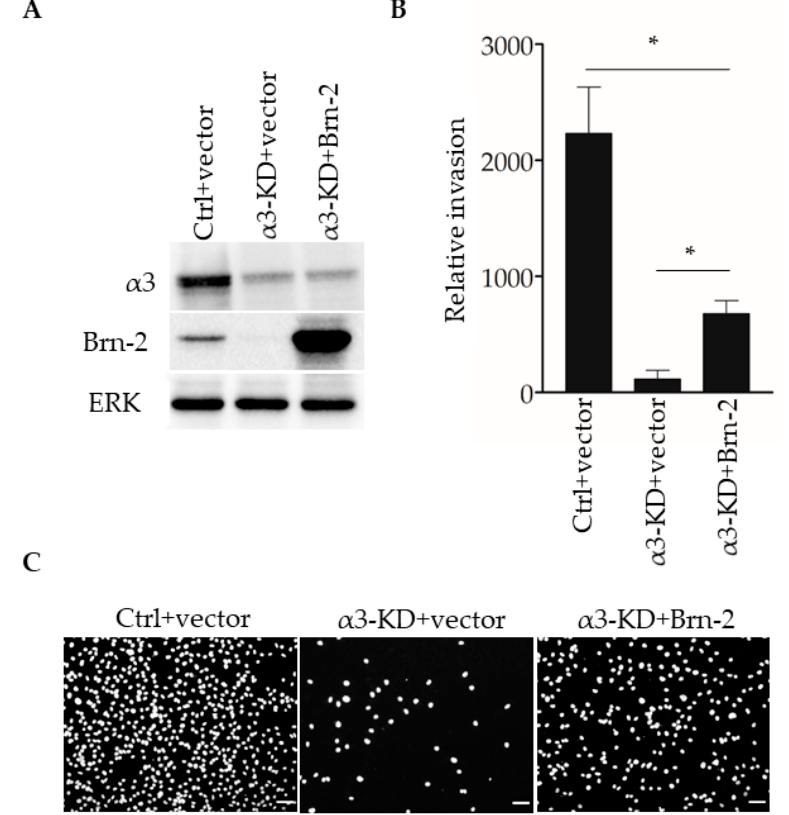
Figure 7. Brn-2 over-expression partially rescues decreased invasion of α 3-knockdown MDA-MB-231 cells. ( A ) Representative Western blots of control (Ctrl) or α 3-KD MDA-MB-231 cells transiently expressing either pHAGE-ZsGreen (+vector) or pHAGE- BRN2 -ZsGreen (+Brn-2) expression plasmid. ( B ) Graph shows relative invasion of α 3-KD cells overexpressing Brn-2 compared to vector alone; n = 3; mean +/ − SEM; * p < 0.05; two-tailed T -test with Bonferroni correction. ( C ) Representative images of invaded cells. Scale bar, 100 µ